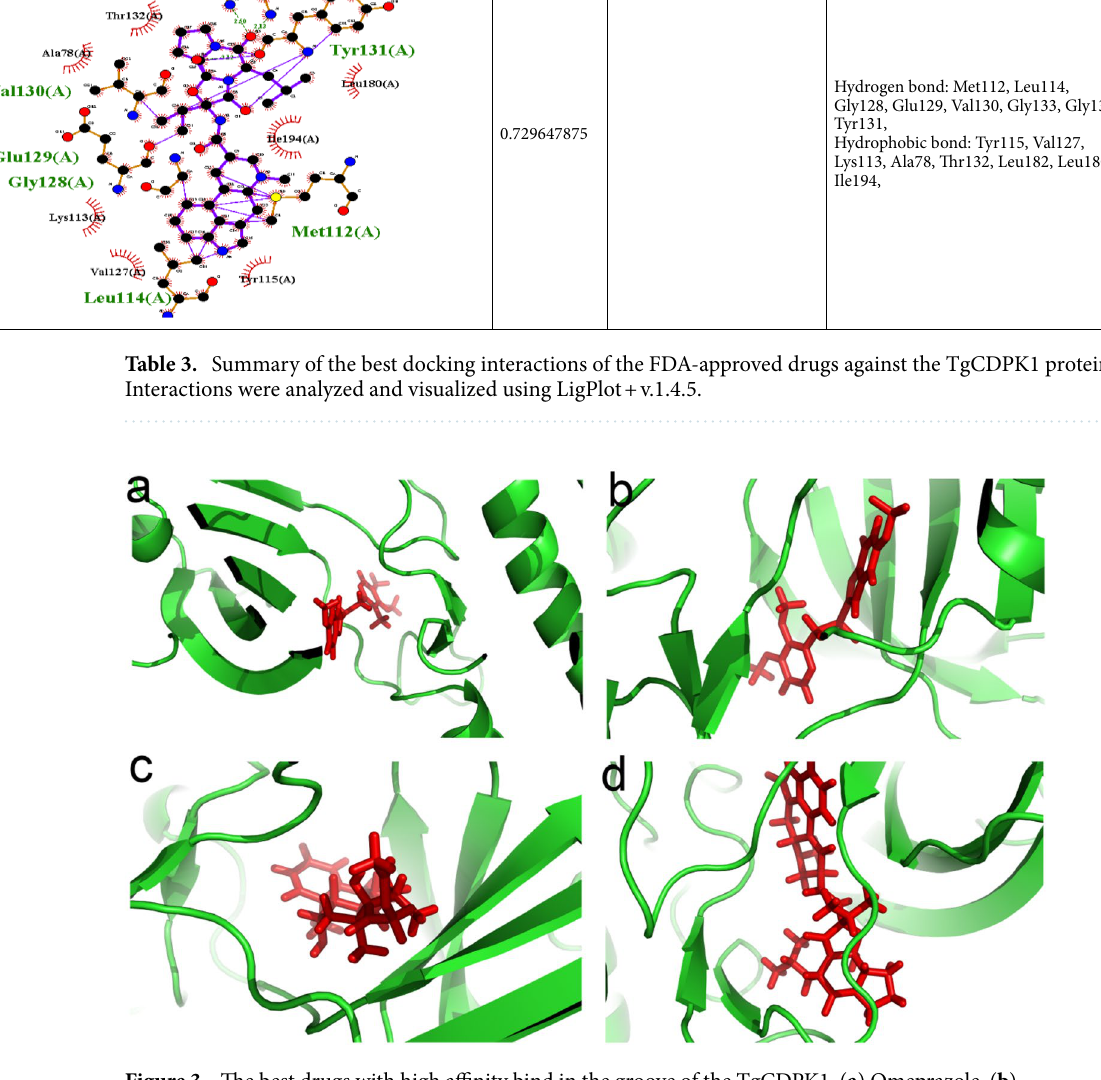
Figure 3. The best drugs with high affinity bind in the groove of the TgCDPK1. ( a ) Omeprazole, ( b ) Pantoprazole, ( c ) Betamethasone, ( d ) Bromocriptine. The figures are created by using PyMOL Version